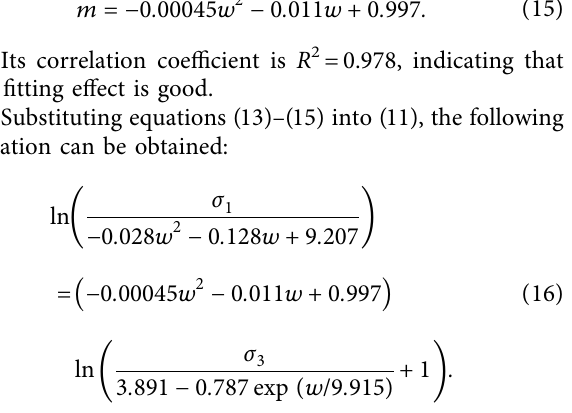
Figure 13: Prediction curve of the Rocker strength criterion considering the water content effect.